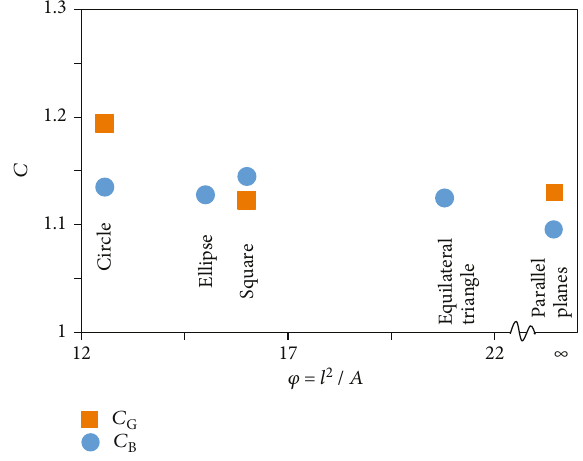
Figure 4: The isoperimetric ration φ versus factor C ( a = 2 b for ellipse